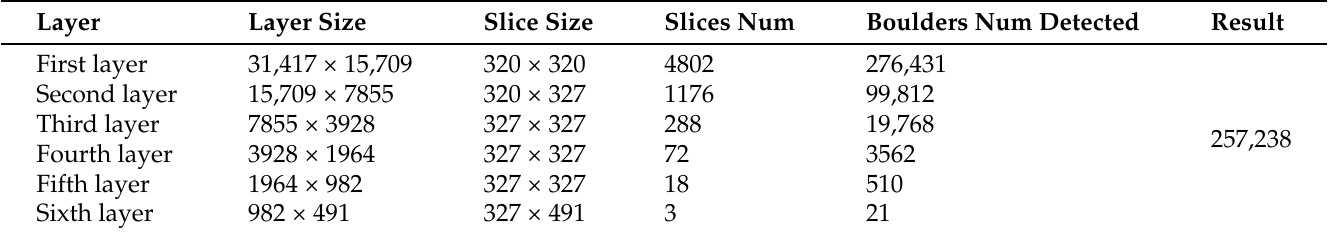
Table 2. The number of boulders detected from the images of Bennu